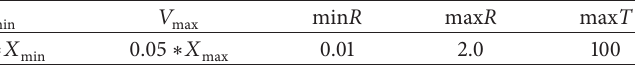
Table 1: Parameter settings for